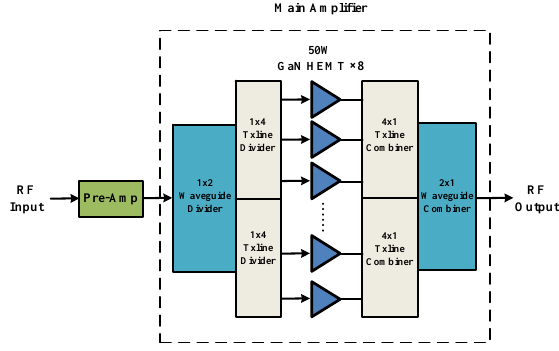
Figure 1: Block diagram of the proposed X-band GaN high-power